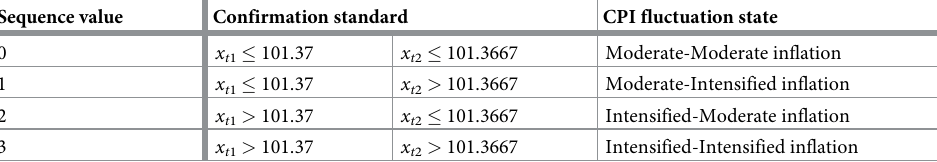
Table 9. Criteria of CPI fluctuation states for HMM with monthly input that vary in four